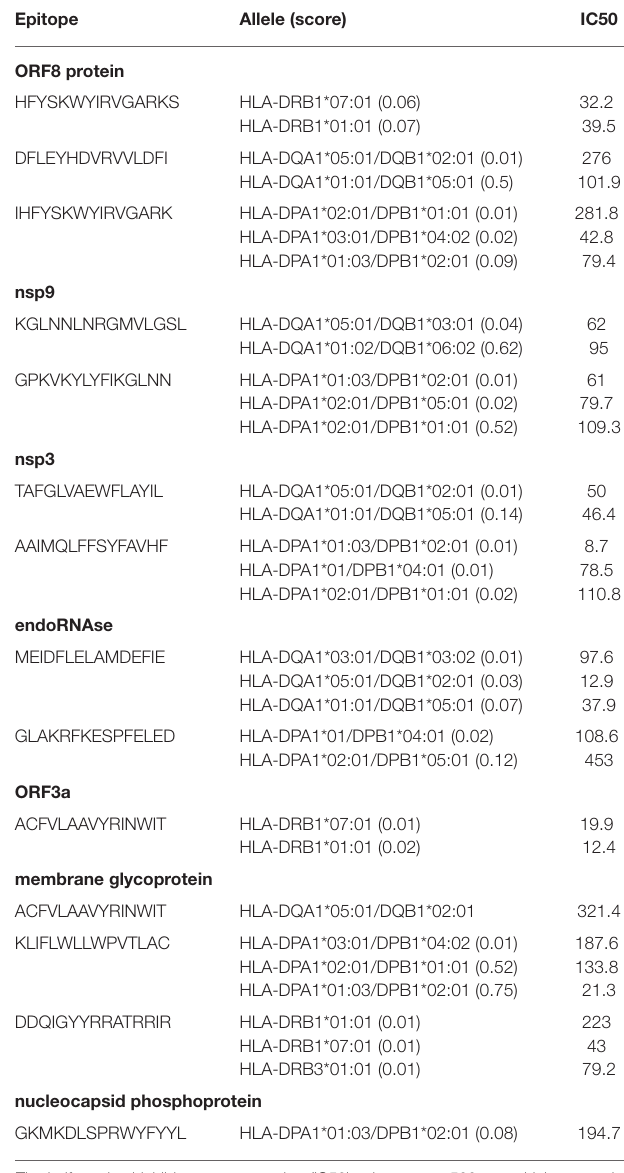
TABLE 3 | Predicted Helper T lymphocyte (HTL) epitopes of SARS-CoV-2 proteins utilized for the construction of a multi-epitope subunit vaccine.